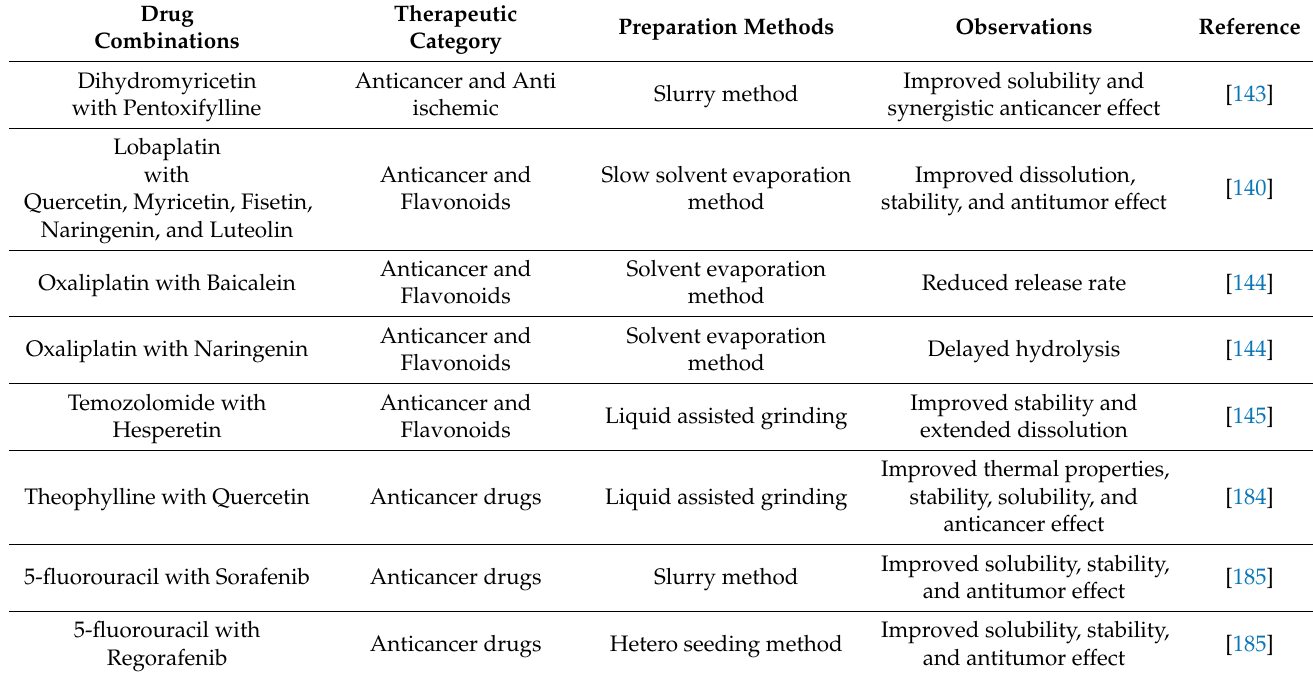
Table 2. Drug–drug cocrystals of anti-cancer drugs reported in the last